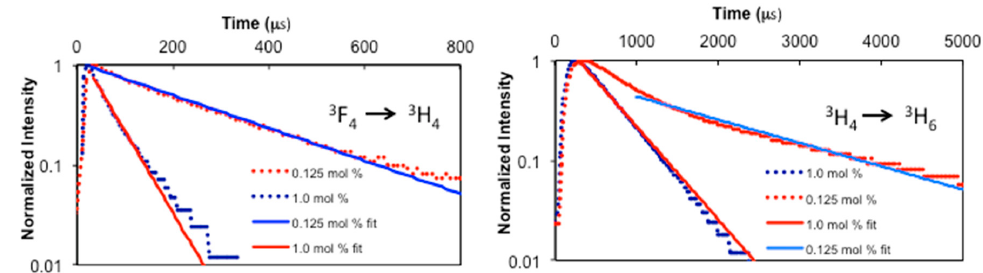
Figure 2. Measured fluorescence decay curves and the exponential fits of the ( a ) 3 F 4 level and ( b ) 3 H 4 level for the two Tm 2 O 3 : TeO 2 -K 2 O-Nb 2 O 5 (TeNbKTm) samples with Tm 2 O 3 concentrations of 1.0 and 0.125 mol % [29].